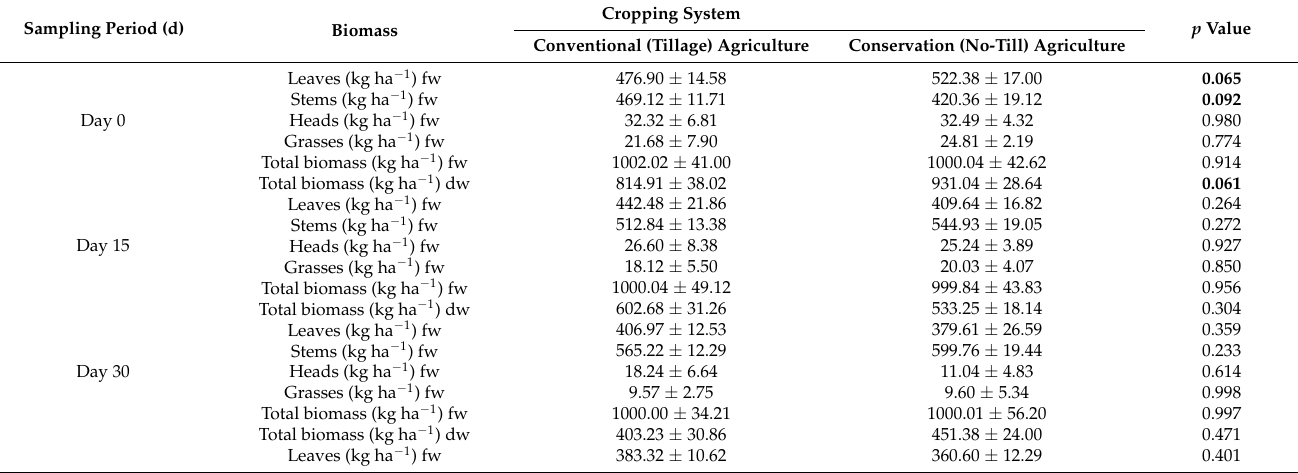
Table 1. Stubble fraction yields of wheat grown under conventional tillage and no-tillage cropping